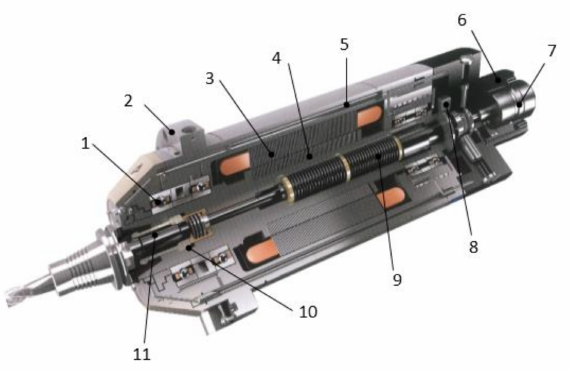
Figure 2. Structure of motorized spindle. 1. Roller bearing; 2. flange; 3. stator; 4. rotor; 5. cooling line; 6. lubrication line; 7. hydraulic cylinder; 8. encoder; 9. disc spring; 10 and 11. broach